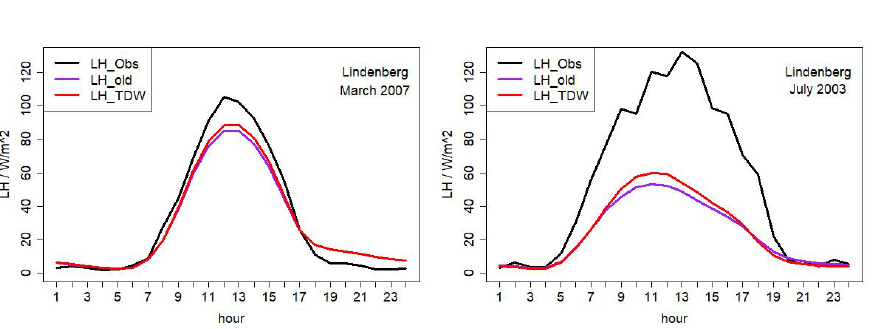
Figure 6. Mean diurnal cycle of latent heat flux during March 2007 and during July 2003 at Lindenberg for the simulations with the standard phenology (_old, –), the simulations with the new phenology (_TDW, –) and the observations (_Obs,